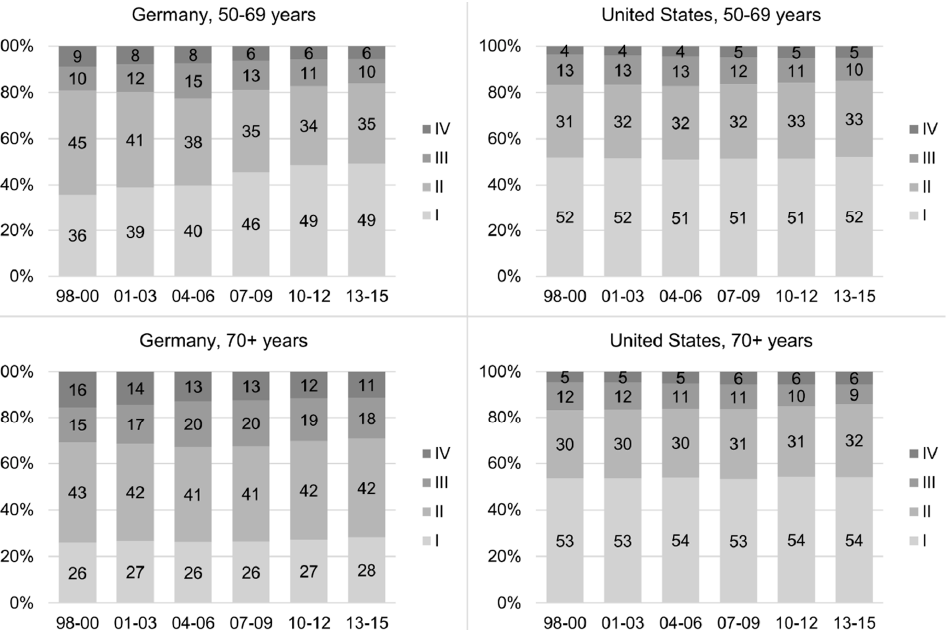
Figure 2. Trends in the distribution of stage (Union internationale contre le cancer (UICC)/ American Joint Committee on Cancer (AJCC), 6th edition) in Germany and the United States by age at diagnosis. Cancers 2020 , 12 , x